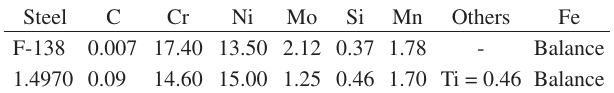
Table 1. Chemical compositions of ASTM F-138 and DIN W. Nr. 1.4970 stainless steels.